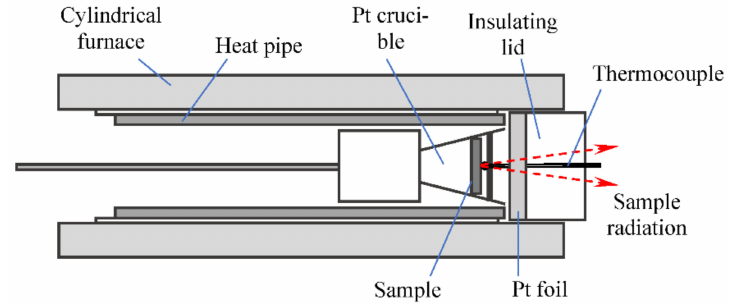
Figure 12. Electric heating device [66] with a cylindrical high-temperature furnace.